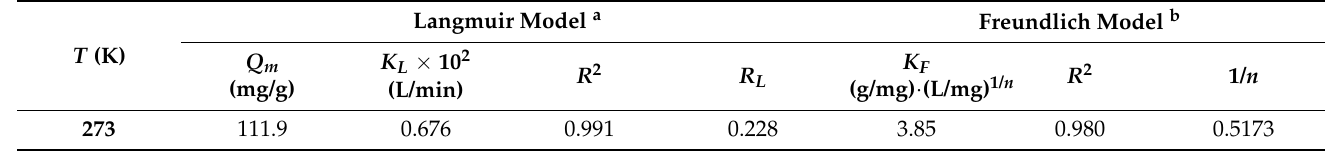
Figure 6. VPA-hydrogel equilibrium adsorption data and model fitting. Table 2. Binding isotherm constants of